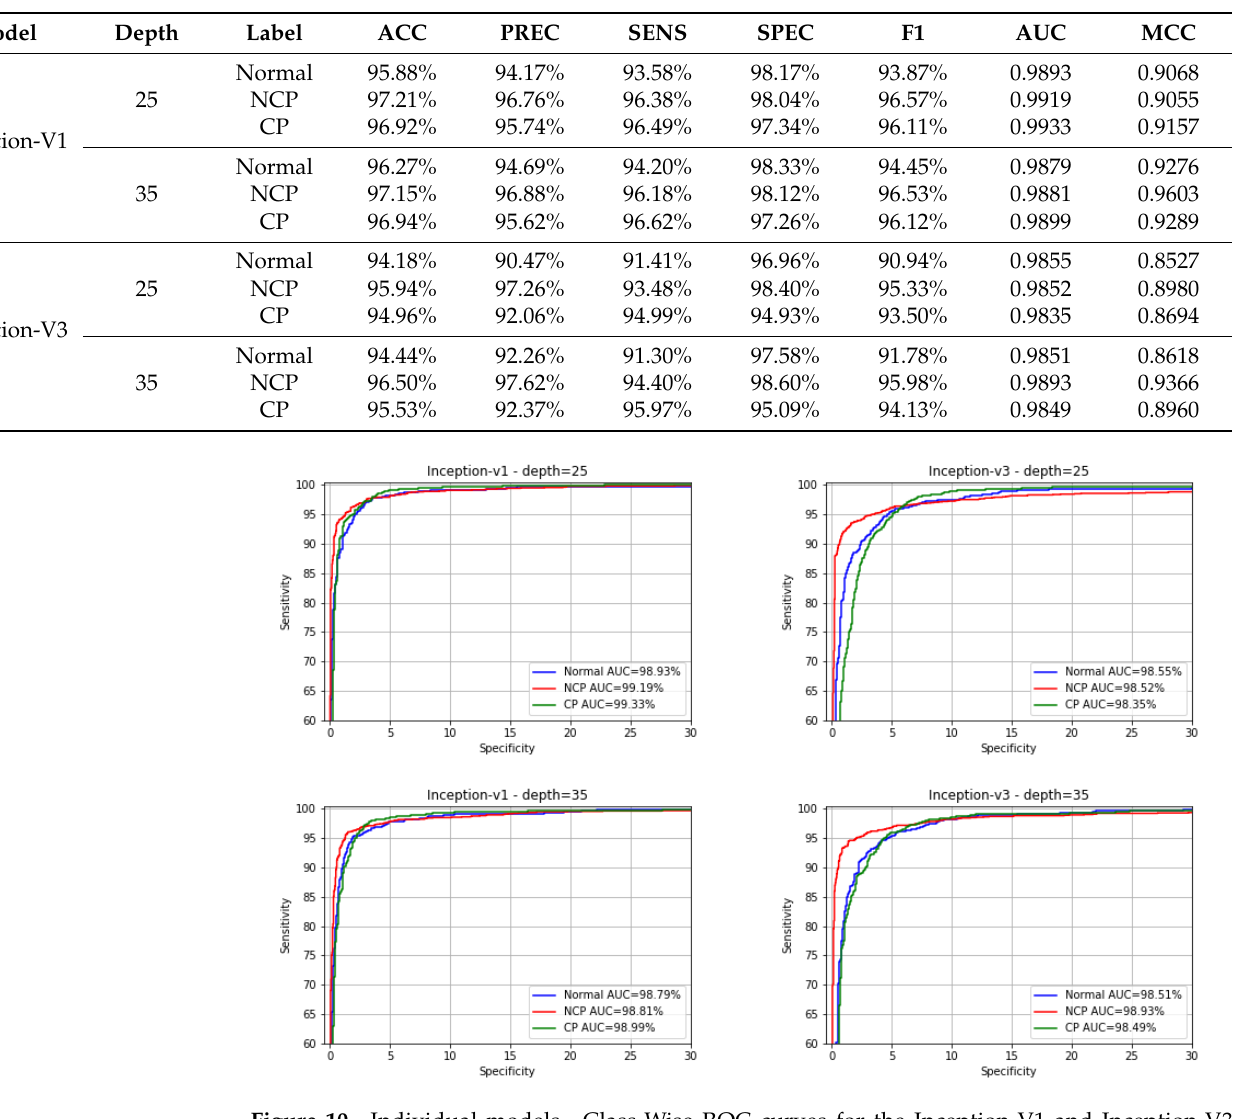
Figure 10. Individual models—Class-Wise ROC curves for the Inception-V1 and Inception-V3 architectures obtained for a CT scan depth of 25 and 35